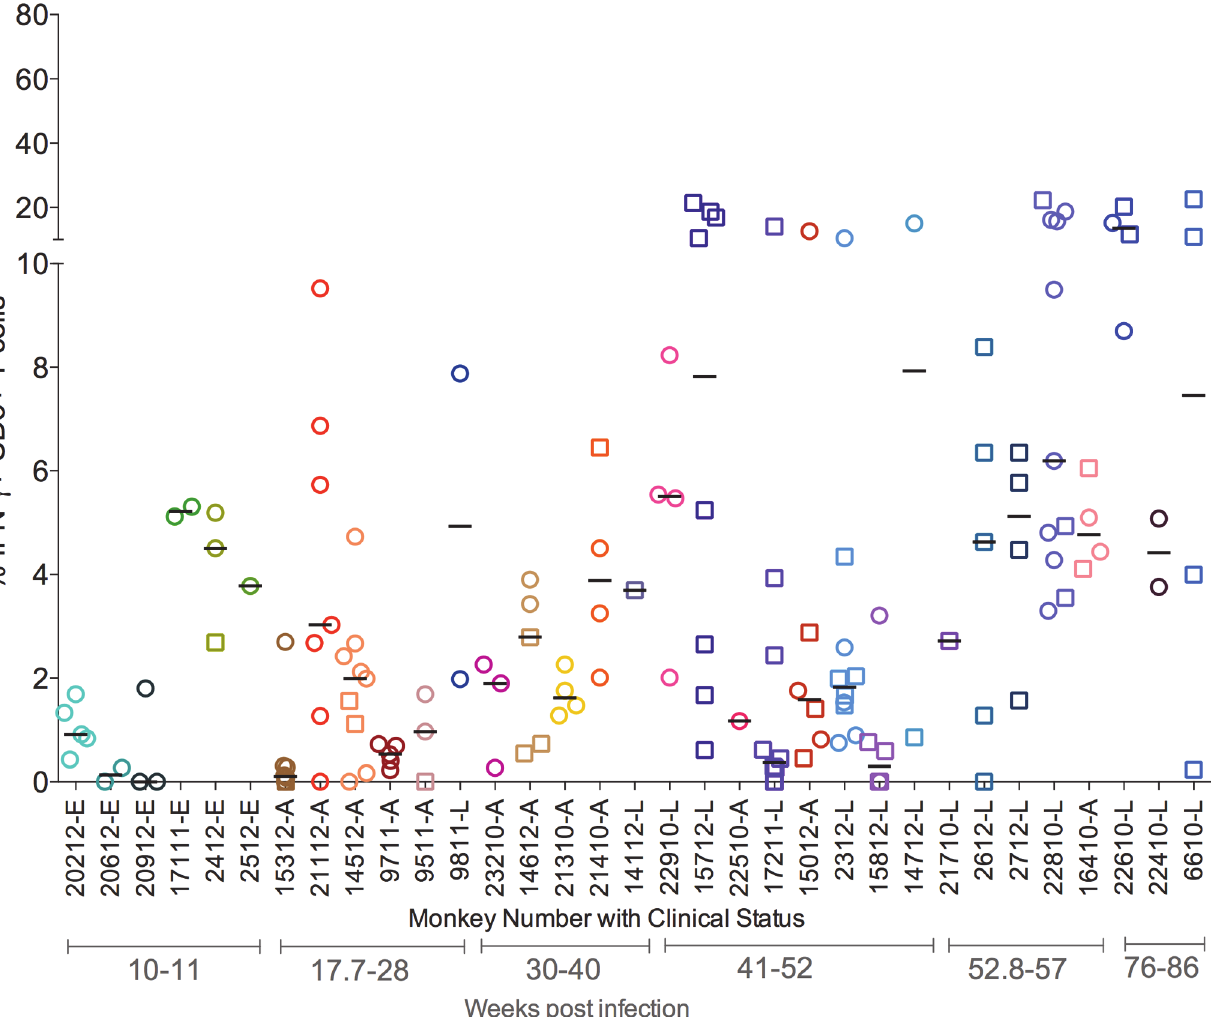
Figure 3. Proportion of T cells with IFN- γ response from each animal included in the study. Each symbol represents an individual granuloma. Each individual granuloma had a distinct cytokine profile and there was a range of cytokine response in each animal. Similar responses were seen for other cytokines (S2 Fig.). Each symbol represents a granuloma. Each color represents an animal. Granulomas are marked based on bacterial burden of the granuloma: non-sterile (Mtb cultured, in open circles) or sterile (in open squares). Clinical status is represented for each animal along with monkey number [ “ E ” : * 11 weeks post infection; “ A ” : Active disease; “ L ” : Latent Infection]. Animals are arranged in the order of increasing post-Mtb infection